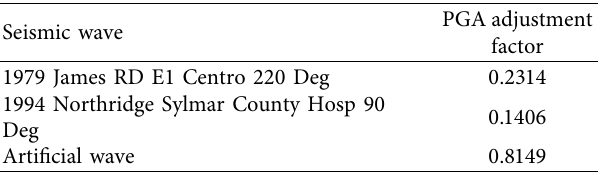
Table 3: PGA adjustment coefficient of each seismic wave under the action of E2